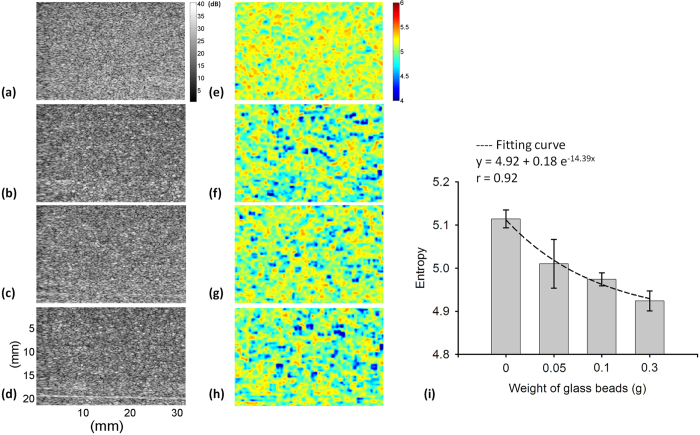
(a–d) B-mode images of Type-B agar phantoms to which 0, 0.05, 0.1, and 0.3 g of glass beads were added (SL = 1; frequency = 6 MHz; scanned at a focus of 1 cm). The dimensions for all images are the same. The grayscale and color bars represent the pixel values (the brightness) of the B-mode and entropy images, respectively. (e–h) Entropy images corresponding to (a–d). (i) Entropy as a function of the weight of glass beads. Data were expressed by mean ± standard deviation.